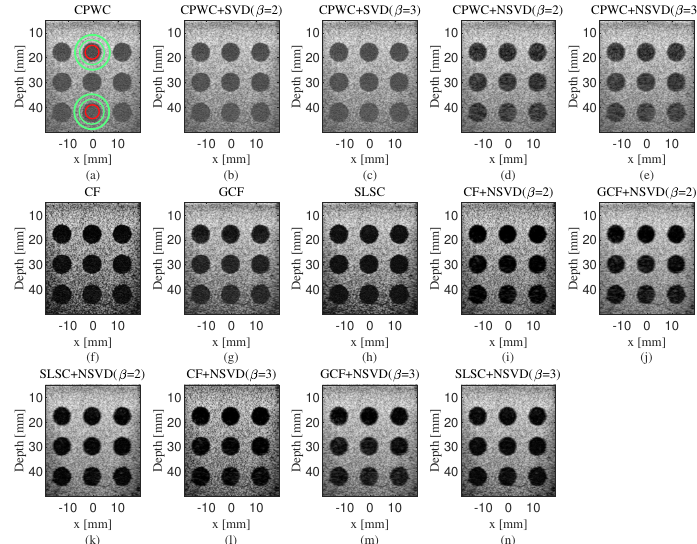
Figure 5. B-mode images of simulated phantom with cyst targets formed by different methods. ( a ) CPWC, ( b ) CPWC+SVD ( β = 2), ( c ) CPWC+SVD ( β = 3), ( d ) CPWC+NSVD ( β = 2), ( e ) CPWC+NSVD ( β = 3), ( f ) CF, ( g ) GCF, ( h ) SLSC, ( i ) CF+NSVD ( β = 2), ( j ) GCF+NSVD ( β = 2), ( k ) SLSC+NSVD ( β = 2), ( I ) CF+NSVD ( β = 3), ( m ) GCF+NSVD ( β = 3), ( n ) SLSC+NSVD ( β = 3). The area in the red circle and between the two green circles indicates the inside and outside the cyst, respectively, used for calculating contrast ratio (CR), contrast-to-noise ratio (CNR), generalized CNR (gCNR), and speckle signal-to-noise ratio